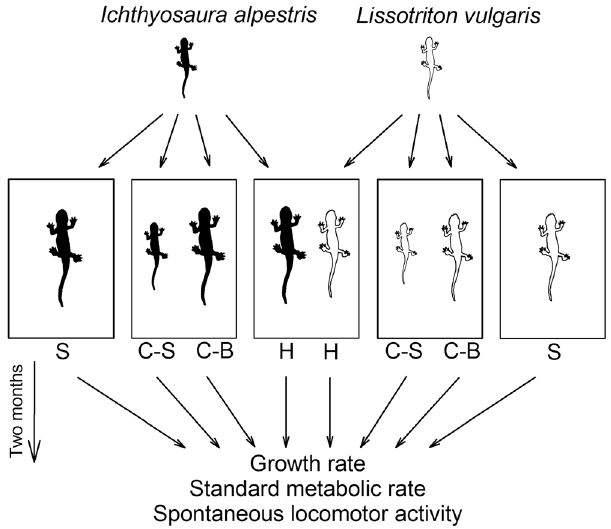
Figure 1. Schematic representation of the experimental design used. Juvenile newts were distributed among tanks separately or in con- and heterospecific pairs. In conspecific pairs, individuals were grouped according to their body size. Note that juveniles of I. alpestris were bigger than those of L. vulgaris . After two months, newt growth rates, standard metabolic rates, and spontaneous locomotor activity were measured at 18 °C. C-B, bigger conspecifics; C-S, smaller conspecifics; H, individuals from heterospecific pairs; S,